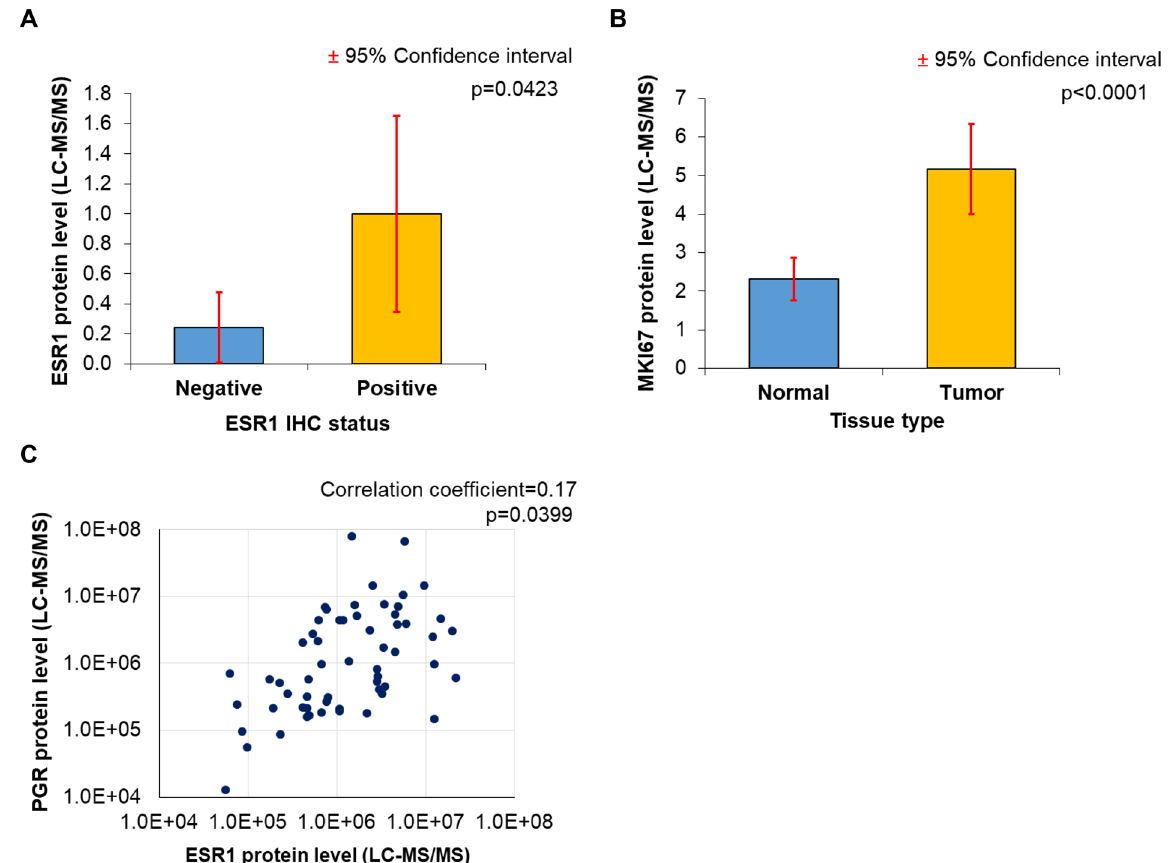
Figure 5. The correlation between ESR1 status by IHC and ESR1 protein expression levels measured by LC–MS/MS ( A ). MKI67 levels measured by LC–MS/MS showed higher expression in tumors than in normal samples in the Tang 2018 dataset (n = 53) ( B ) . Correlation between ESR1 and PGR protein expression levels in LC–MS/MS data ( C